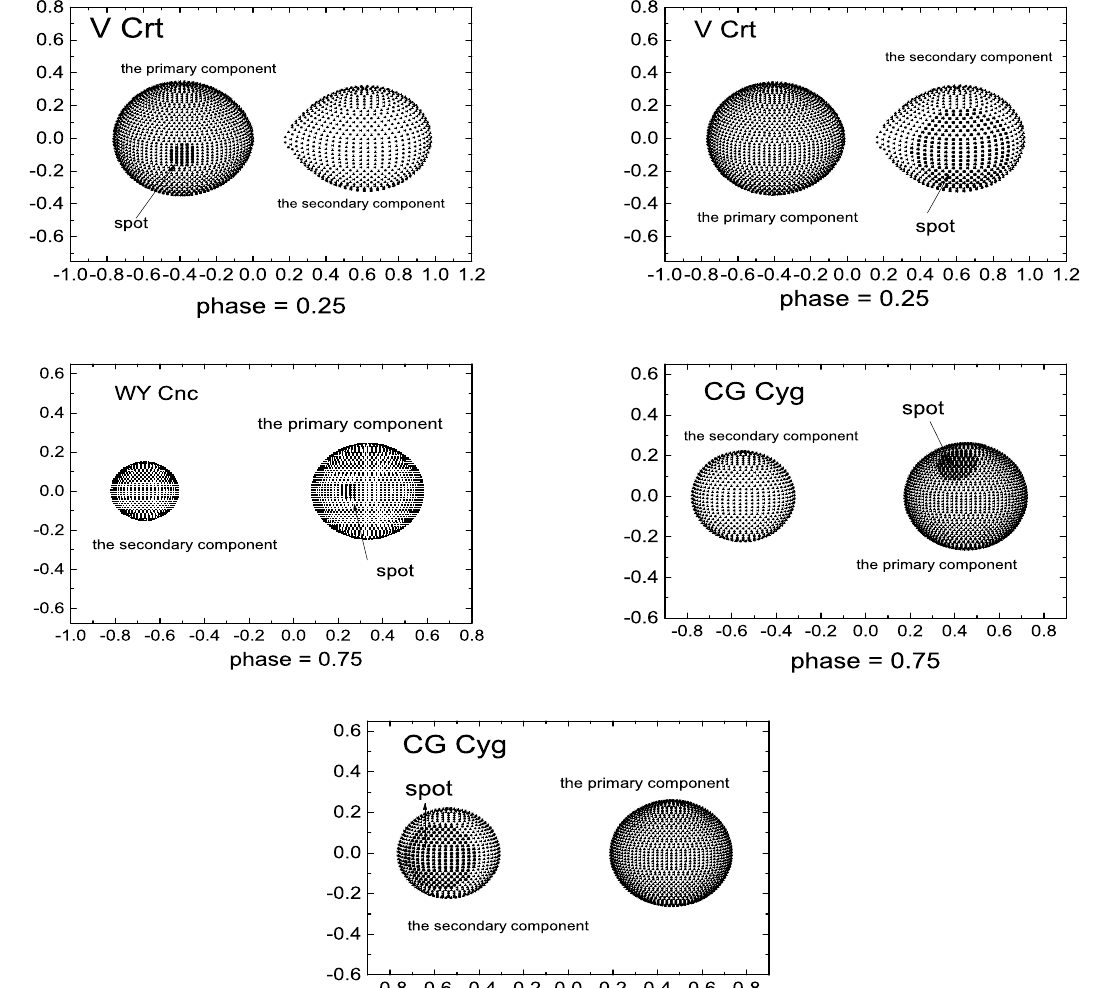
Figure 6. Spot structures of V Crt, WY Cnc and CG